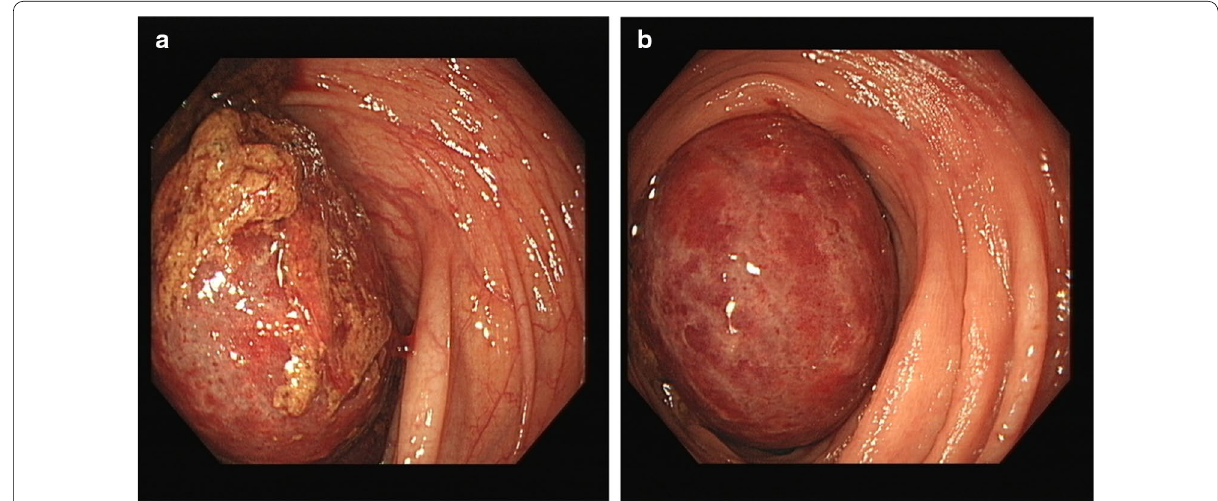
Fig. 1 Endoscopic images captured during flexible sigmoidoscopy; obvious intramural globular mass detected at the proximal aspect of the transverse colon